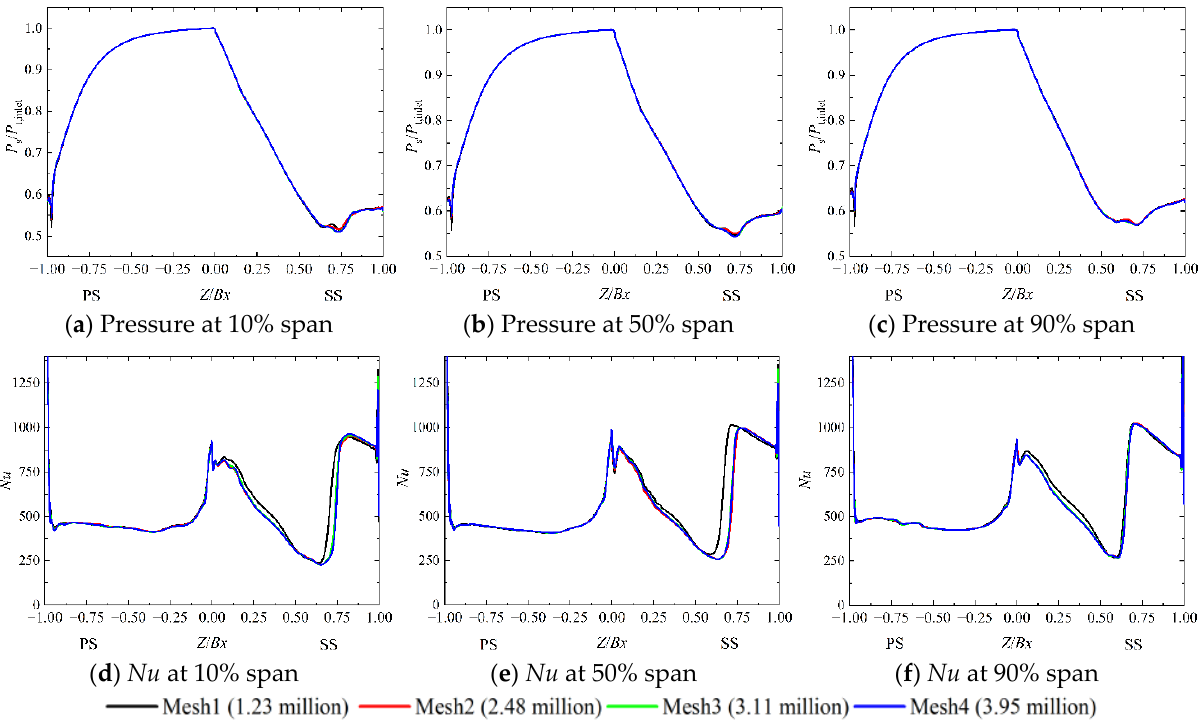
Figure 8. Mesh independence analysis based on pressure and Nusselt number at three spans.